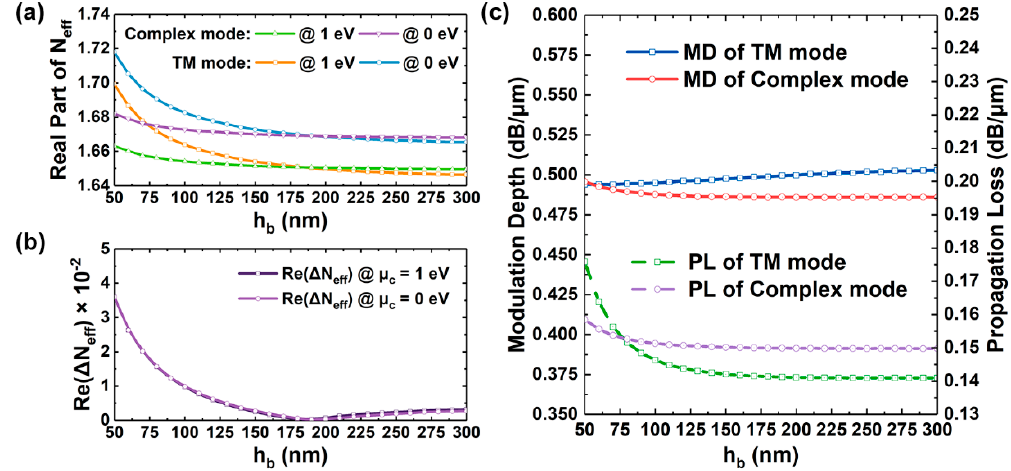
Figure 6. ( a – c ) are Re( N eff ), Re( ∆ N eff ), and modulation depth (MD) as well as propagation loss (PL) of the TM mode and complex mode in the DBOSW modulator as a function of h b , respectively.